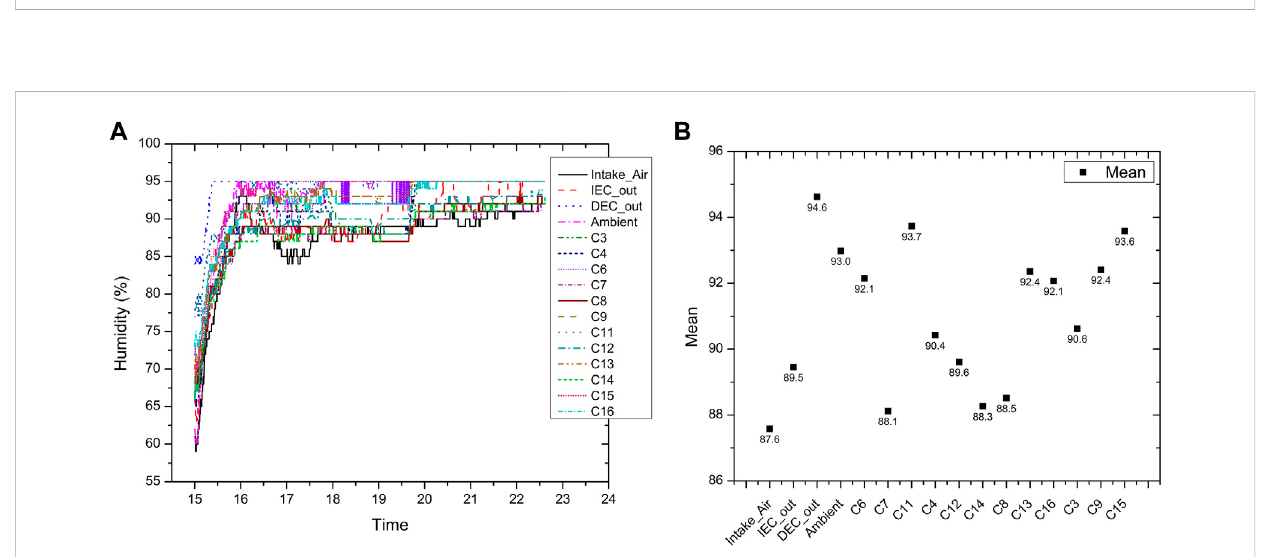
FIGURE 5 Relative humidity captured from (A) 1500 h until 2211 h and (B) corresponding mean